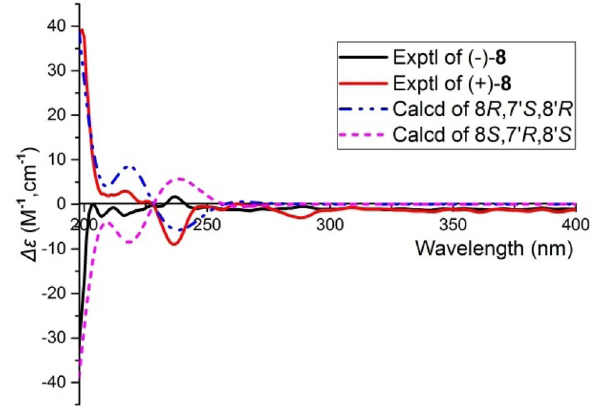
Fig. 6 Comparison of calculated ECD spectra for (7 S ,7 ′ R )- 9 and (7 R ,7 ′ S )- 9 with the experimental spectra of (+) -9 and (−) -9 in MeOH. σ = 0.3 eV; shift = –3